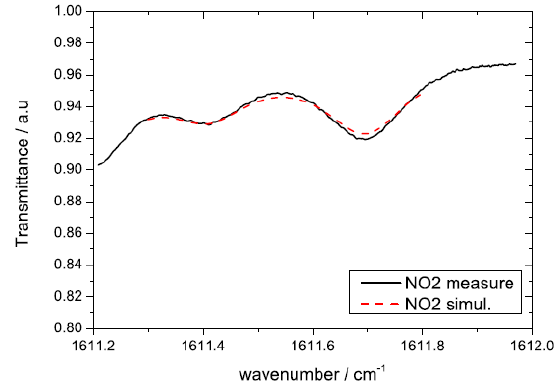
Figure 23. Transmittance spectrum of NO 2 produced by the jet at atmospheric pressure combined with a real-time fit [54], © IOP Publishing. Reproduced with permission. All rights reserved.